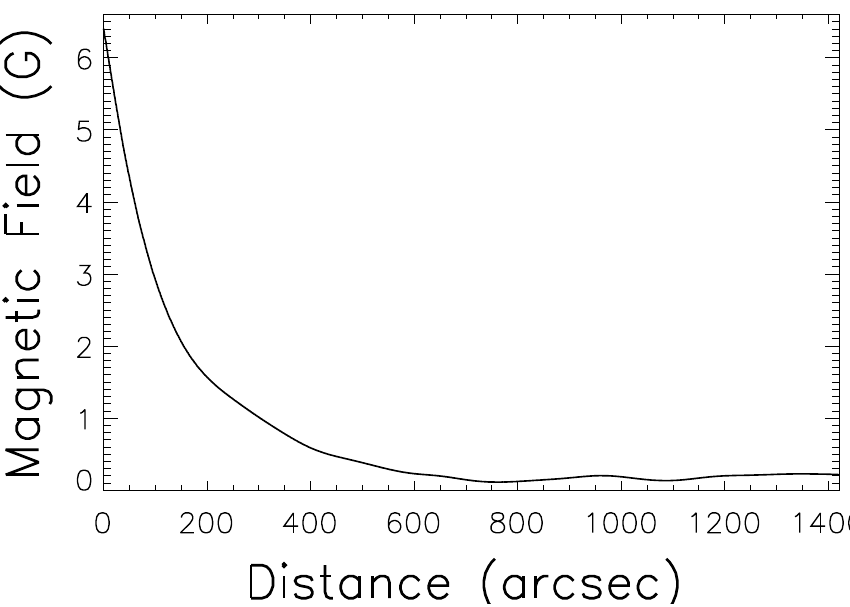
Figure 7. Distribution of the magnetic field strength at the altitude of 0.1 R (cid:12) along the slice S 3